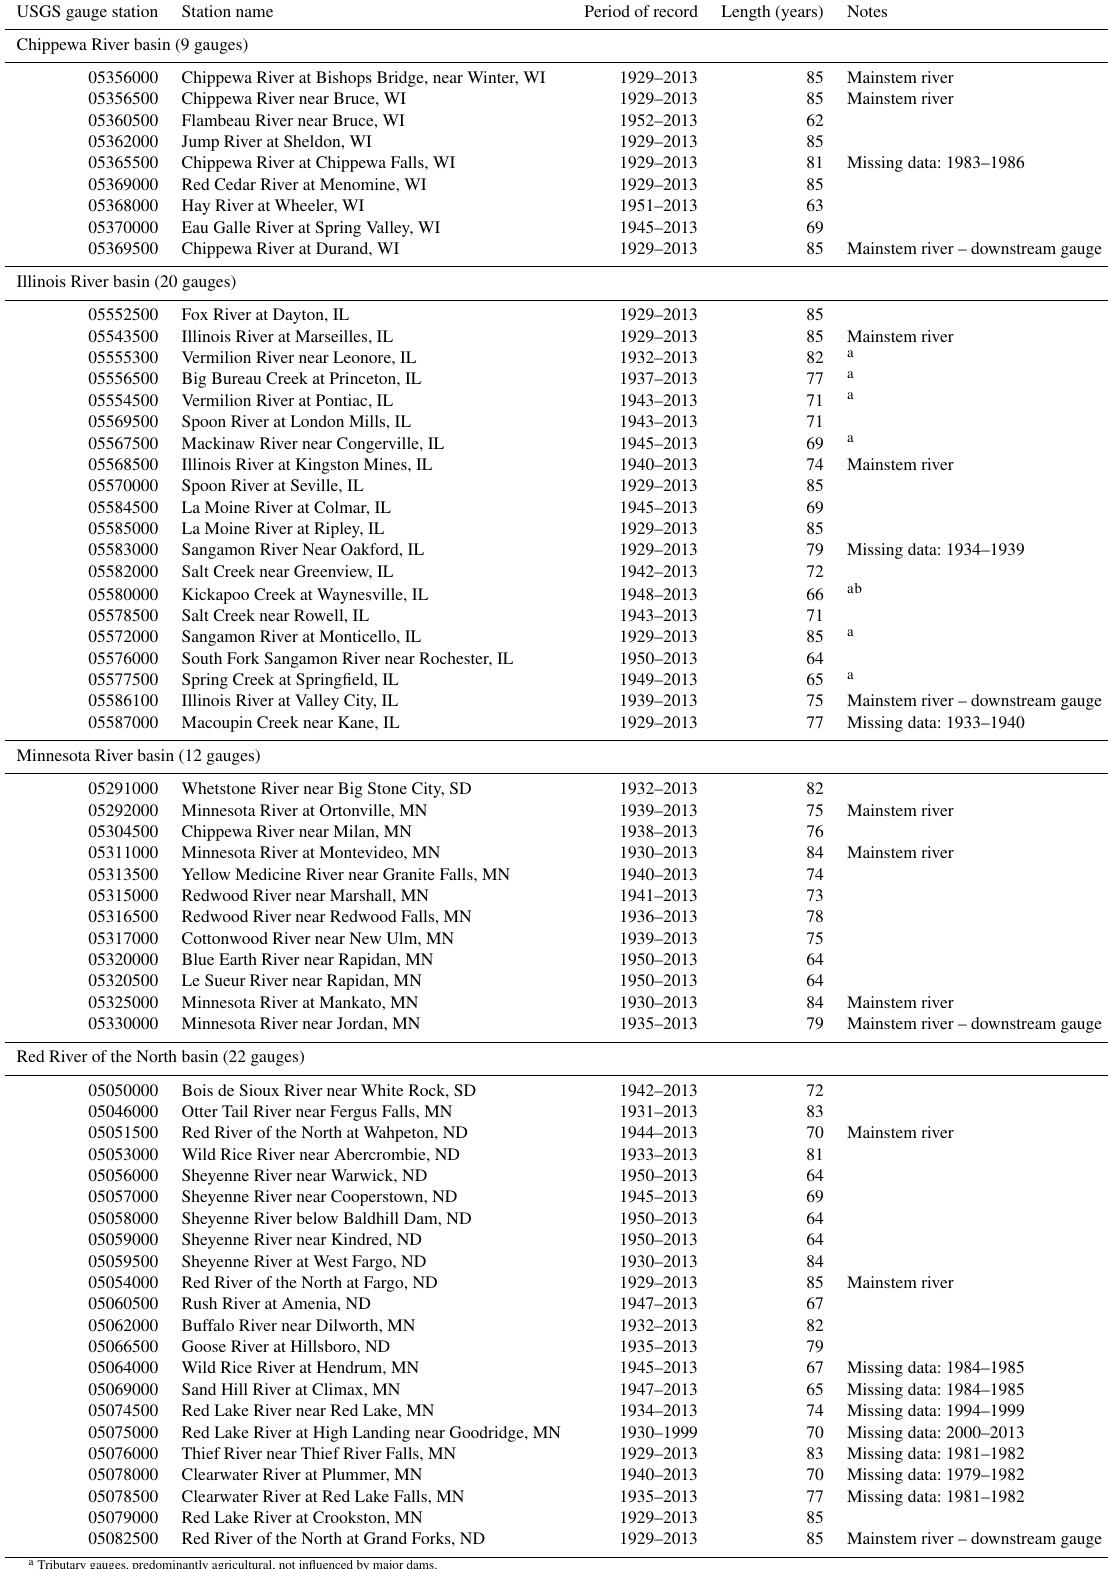
Table 1. United States Geological Survey (USGS) stream gauge stations listed by study